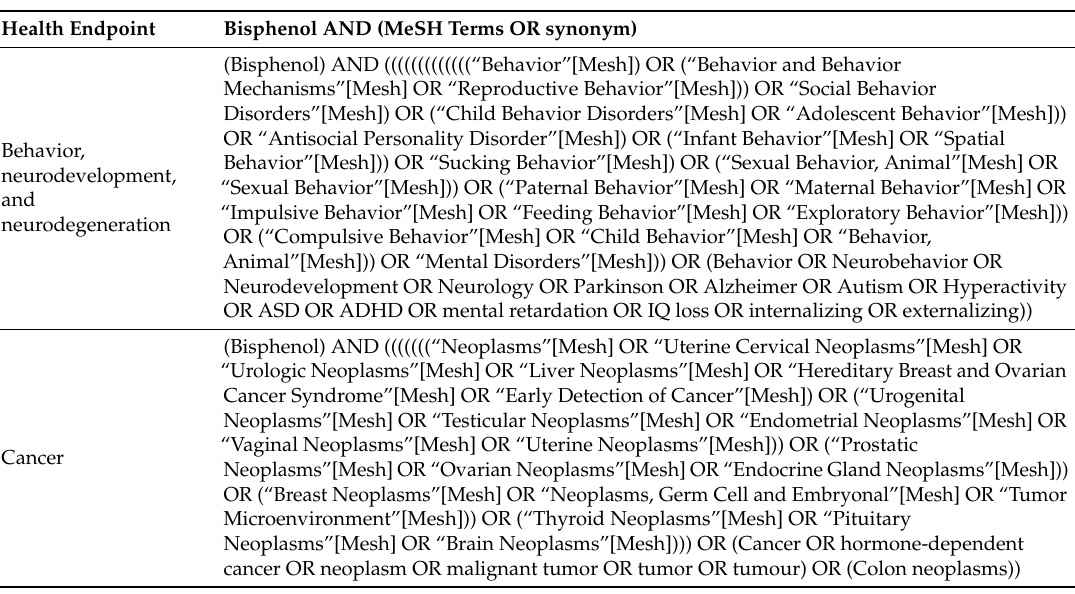
Table A1. Used in the two Pubmed database searches performed at the turn of the year